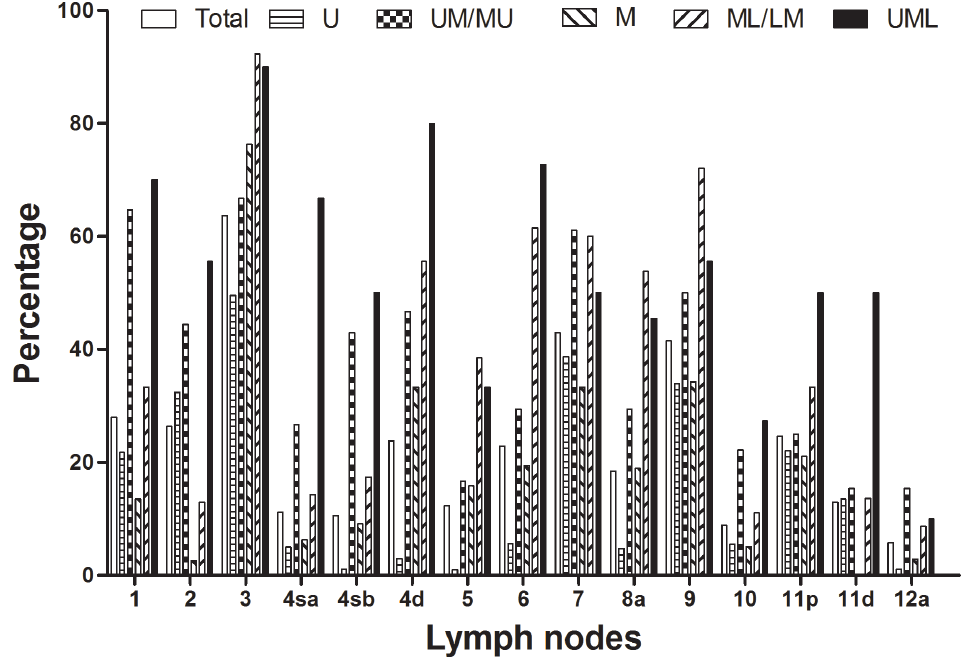
Figure 1. Metastatic rates of harvested lymph nodes according to tumor locations.